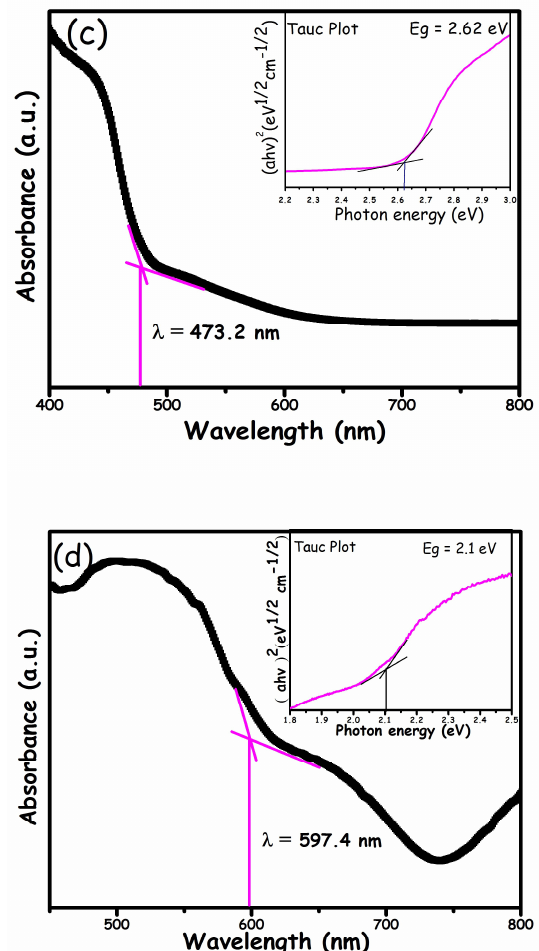
Figure 8. XPS valence band spectra with insets representing magnified spectra of ( a ) g-C 3 N 4 and ( b ) α -Fe 2 O 3 , and absorbance spectra with insets representing the Tauc plots for ( c ) g-C 3 N 4 and ( d ) α -Fe 2 O 3 .